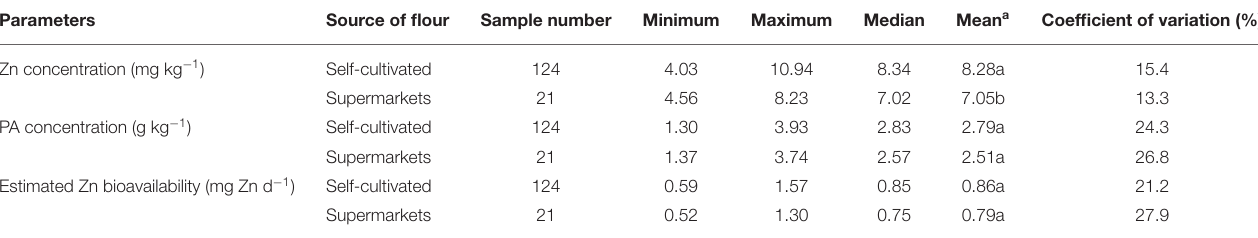
TABLE 1 | Zinc (Zn) and phytic acid (PA) concentrations and estimated Zn bioavailability in the wheat flour collected from the rural households in Quzhou County. Parameters Source of flour Sample number